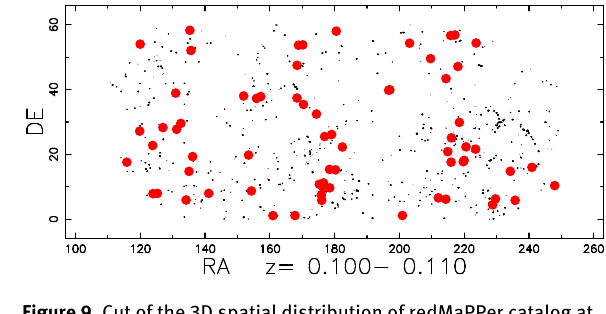
Figure 9. Cut of the 3D spatial distribution of redMaPPer catalog at